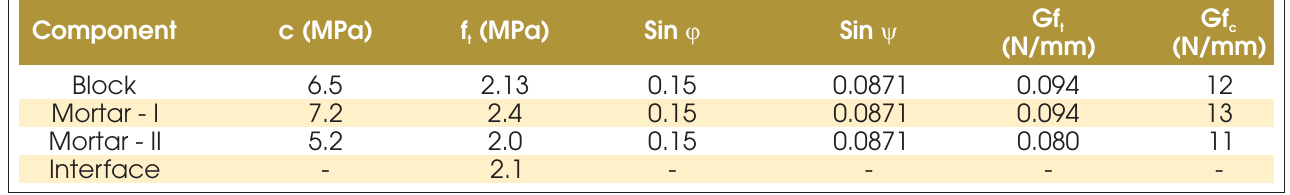
Figure 15 – Axial and lateral stress-strain curves of the prism I-2